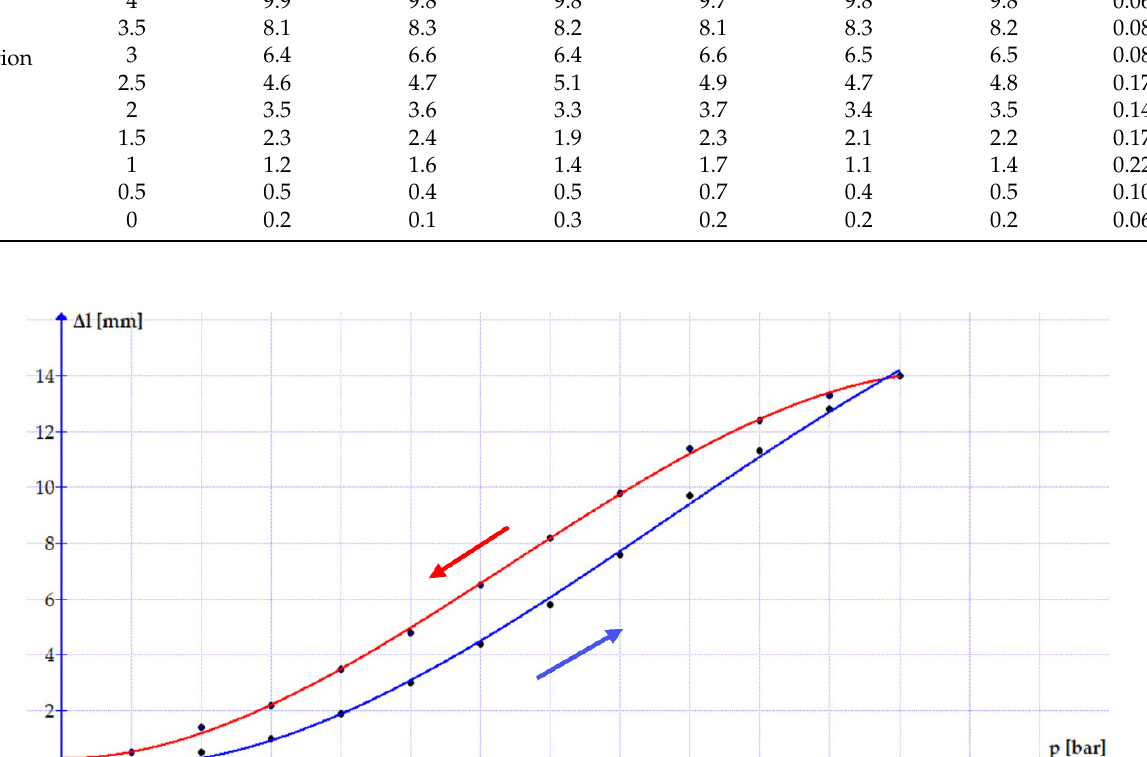
In this case, the values measured at the deflation of the muscle are higher than the values measured at inflation, the maximum distance between those being 2.4 mm at a pressure of 3.5 bar.